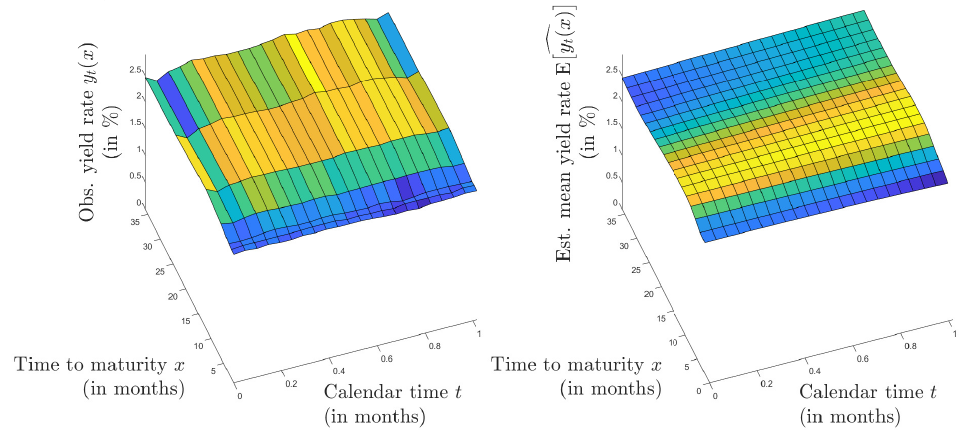
Figure 5. Observed yield curve rates (left) and estimated mean yield curve rates (right) for Jan- uary